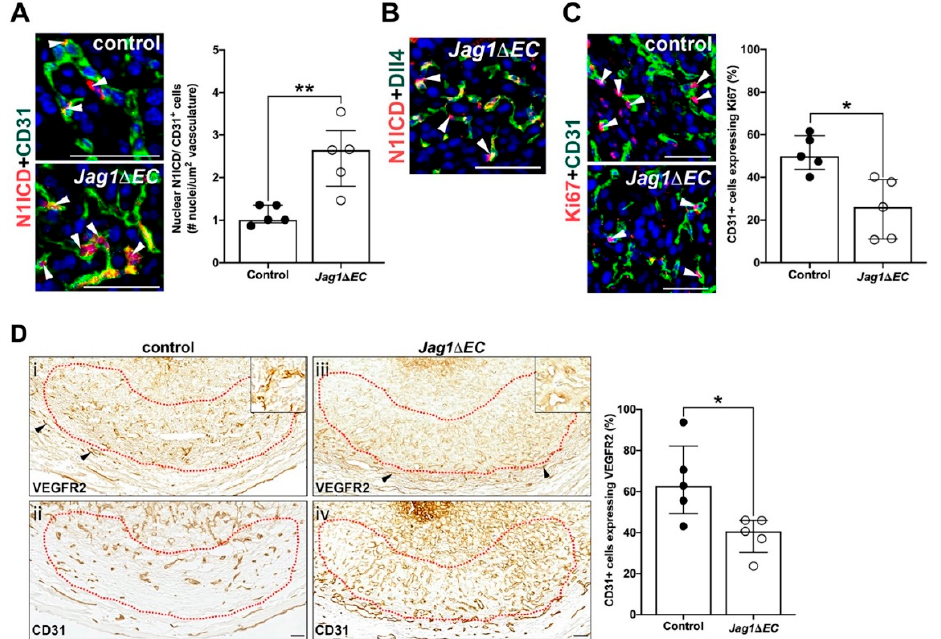
Figure 7. Increased Notch signaling in the anti-mesometrial decidua decreases EC proliferation and expression of VEGFR2. ( A – C ) High magnification images of sections double stained to detect expression of N1ICD and CD31, Dll4 or Ki67. ( A ) Expression of the N1ICD in CD31 + ECs in the AMR of Cdh5-Cre ERT2 control and Jag1 ∆ EC pregnancies was determined by double staining IF for N1ICD and CD31. Representative images of control and Jag1 Δ EC implantation sites are shown. Nuclear expression of N1ICD (white arrowheads) is increased in CD31 + ECs in the AMR of Jag1 Δ EC mutants ( n = 5) as compared to Cdh5-Cre ERT2 controls ( n = 5). ( B ) N1ICD and Dll4 are expressed in adjacent cells in the AMR (white arrowheads) of Jag1 ∆ EC pregnancies. ( C ) EC proliferation in the AMR of Cdh5- Cre ERT2 control and Jag1 ∆ EC pregnancies was determined by double staining IF for EC proliferation marker, Ki67 and CD31. Representative images of control and Jag1 Δ EC implantation sites are shown. Ki67 expression (white arrowheads) is decreased in CD31 + ECs in the AMR of Jag1 Δ EC mutants ( n =